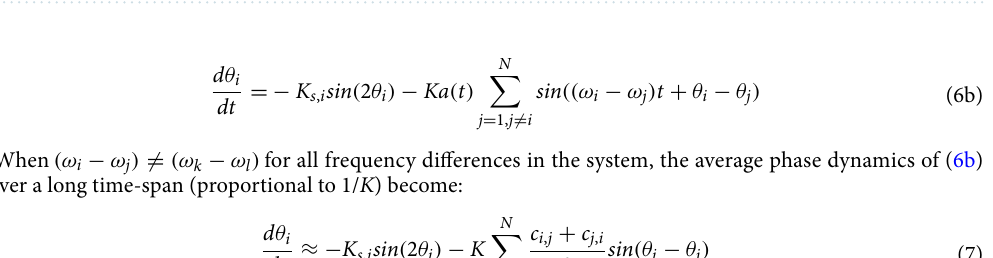
Figure 3. ( a ) An undirected unweighted graph of size N = 6 with all-to-all connections, ( b ) numerical simulations of the proposed oscillator-based IM, ( c ) solutions found for 100 independent simulations with random initial conditions, and ( d ) average max-cut probability for ten randomly generated graphs of size N = 6 (100 runs of each graph) for different simulation times t end